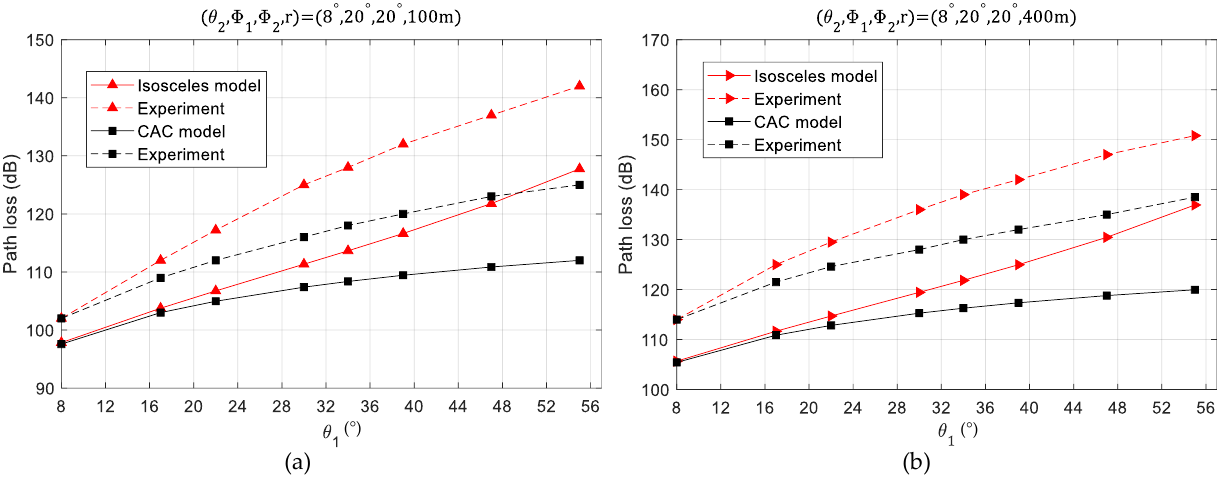
Figure 6. Simulation and experiment of the relationship between different launch angles and path loss at r = 100 m and r = 400 m: ( a ) (𝜃 2 , 𝜙 1 , 𝜙 2 , 𝑟 = 8 ° , 20 ° , 20 ° , 100 m) , ( b ) ( 𝜃 2 , 𝜙 1 , 𝜙 2 , 𝑟 = 8 ° , 20 ° , 20 ° , 400 m) .